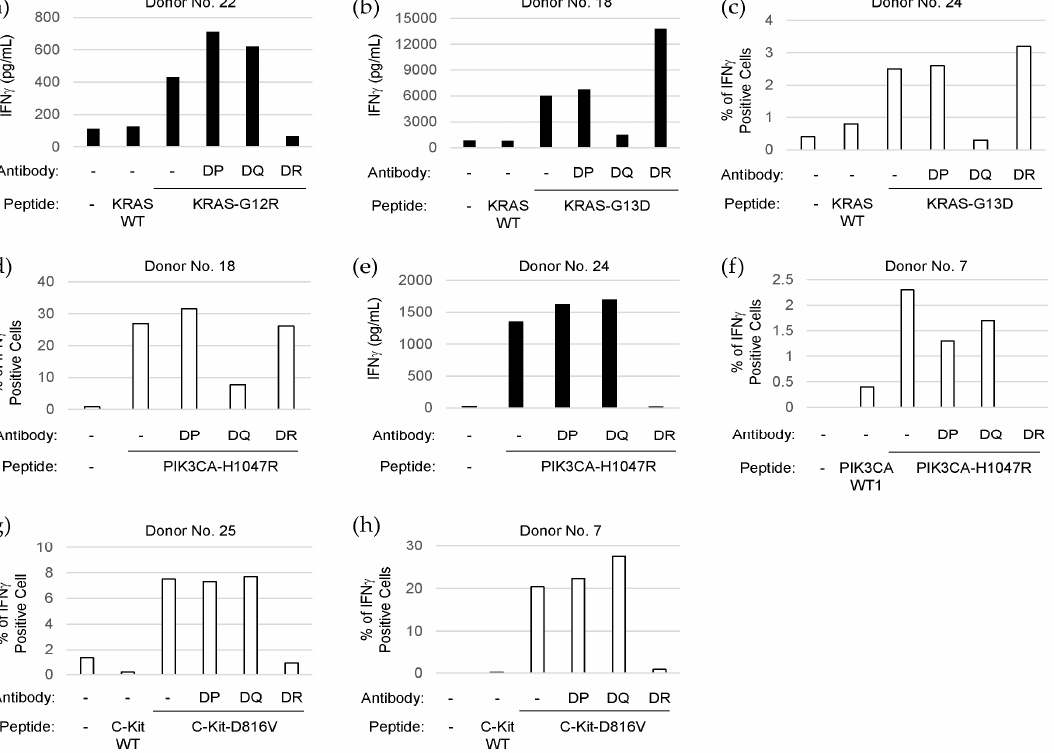
Figure 2. Determination of human leukocyte antigen (HLA) class II restriction of neoantigen-specific CD4 + T cells by blocking assay. Neoantigen-specific CD4 + T cells were stimulated without or with synthetic peptides (mutated or corresponding wild-type peptides) in the absence or presence of anti-HLA Class II antibody (anti-HLA-DP, -DQ, or -DR) to determine HLA class II restriction. Amounts of IFN γ secreted in the culture supernatant (closed bar) were determined by ELISA (( a ) KRAS-G12R-specific cells from donor No. 22; ( b ) KRAS-G13D-specific cells from donor No. 18; and ( e ) PIK3CA-H1047R-specific cells from donor No. 24). The percentages of IFN γ positive cells in CD4 + T cells (open bar) were determined by flow cytometry (( c ) KRAS-G13D-specific cells from donor No. 24; ( d ) PIK3CA-H1047R-specific cells from donor No. 18; ( f ) PIK3CA-H1047R-specific cells from donor No. 7; ( g ) C-Kit-D816V-specific cells from donor No. 25; and ( h ) C-Kit-D816V-specific cells derived from donor No. 7).